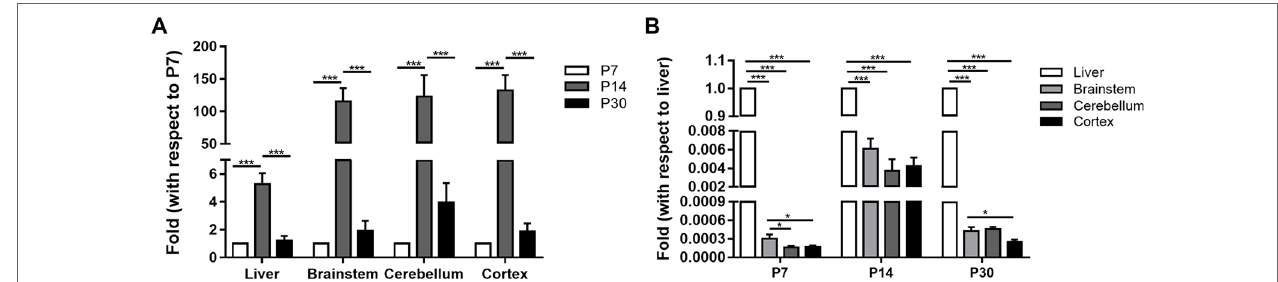
FIGURE 1 | The relative expression of CYP1A2 mRNA in the liver and brain. (A) The fold changes of CYP1A2 mRNA expression with respect to 7-day-old SD rats. (B) The fold changes of CYP1A2 mRNA expression with respect to liver. GAPDH was used for normalization. Data are expressed as the means ± standard deviation (SD) of five to six biological replicates. *p < 0.05, ***p < 0.001. P, postnatal